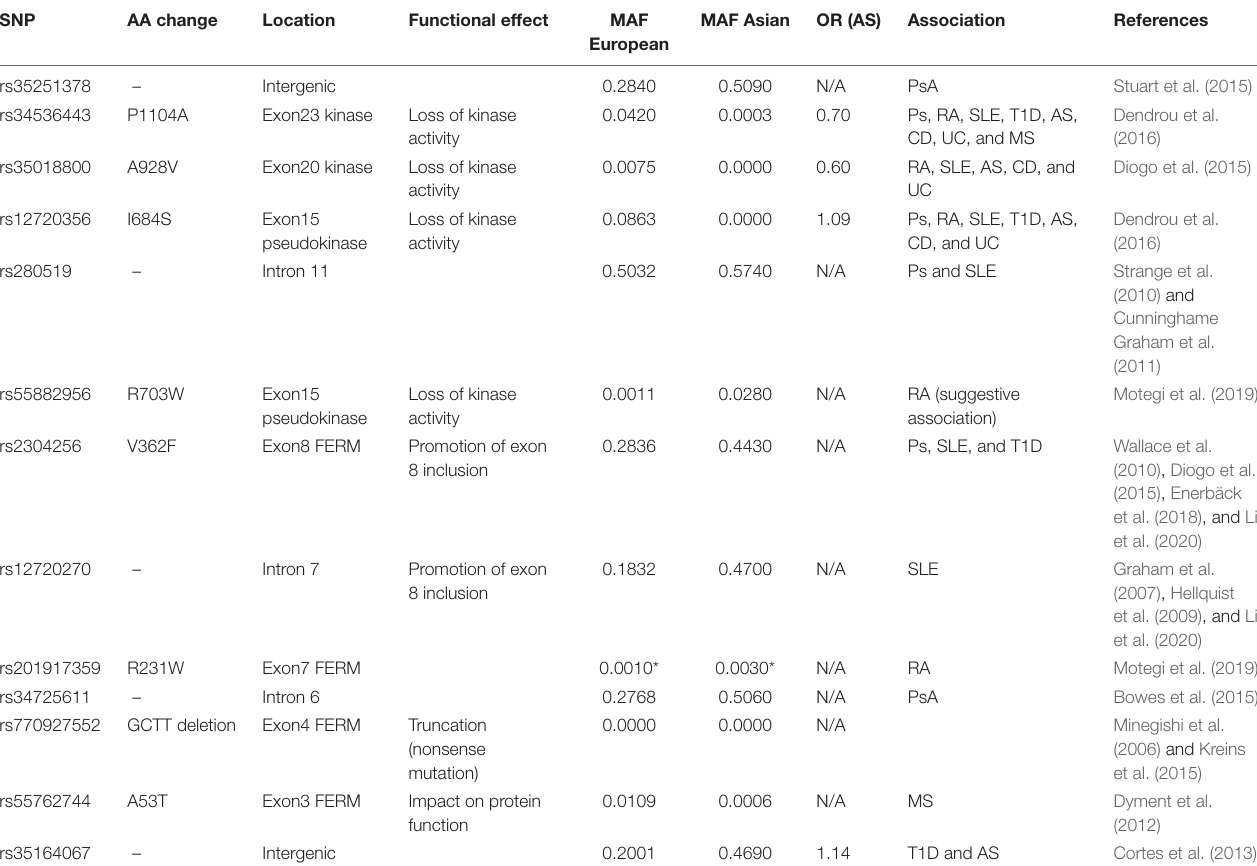
TABLE 1 | Tyrosine kinase 2 ( TYK2 ) locus single-nucleotide polymorphisms (SNPs) associated with ankylosing spondylitis (AS) or related autoimmune